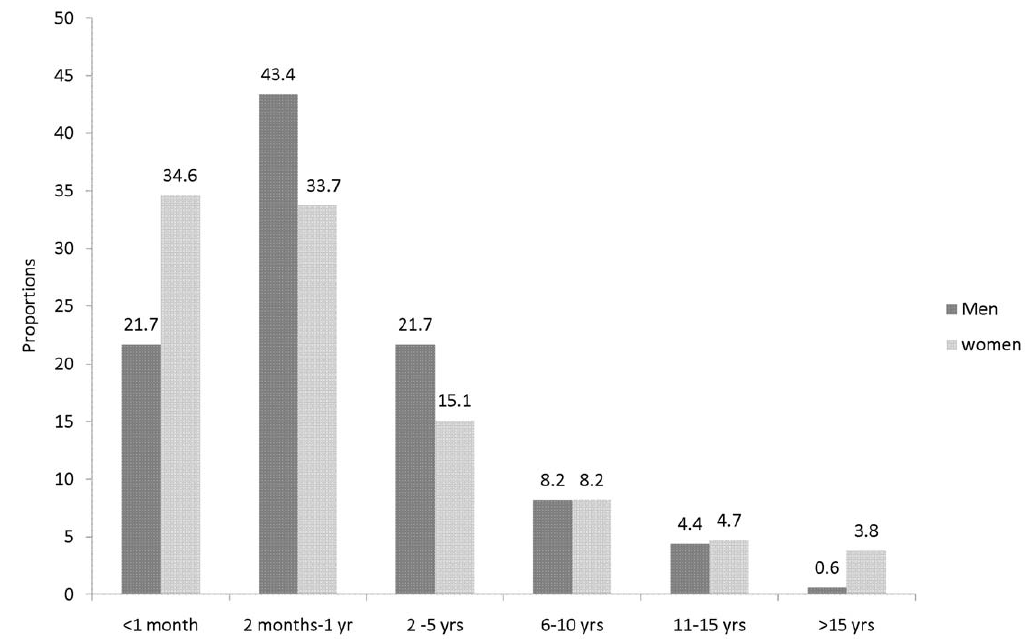
Figure 1. Preferred age for medical circumcision of male children stratified by the parent’s gender.